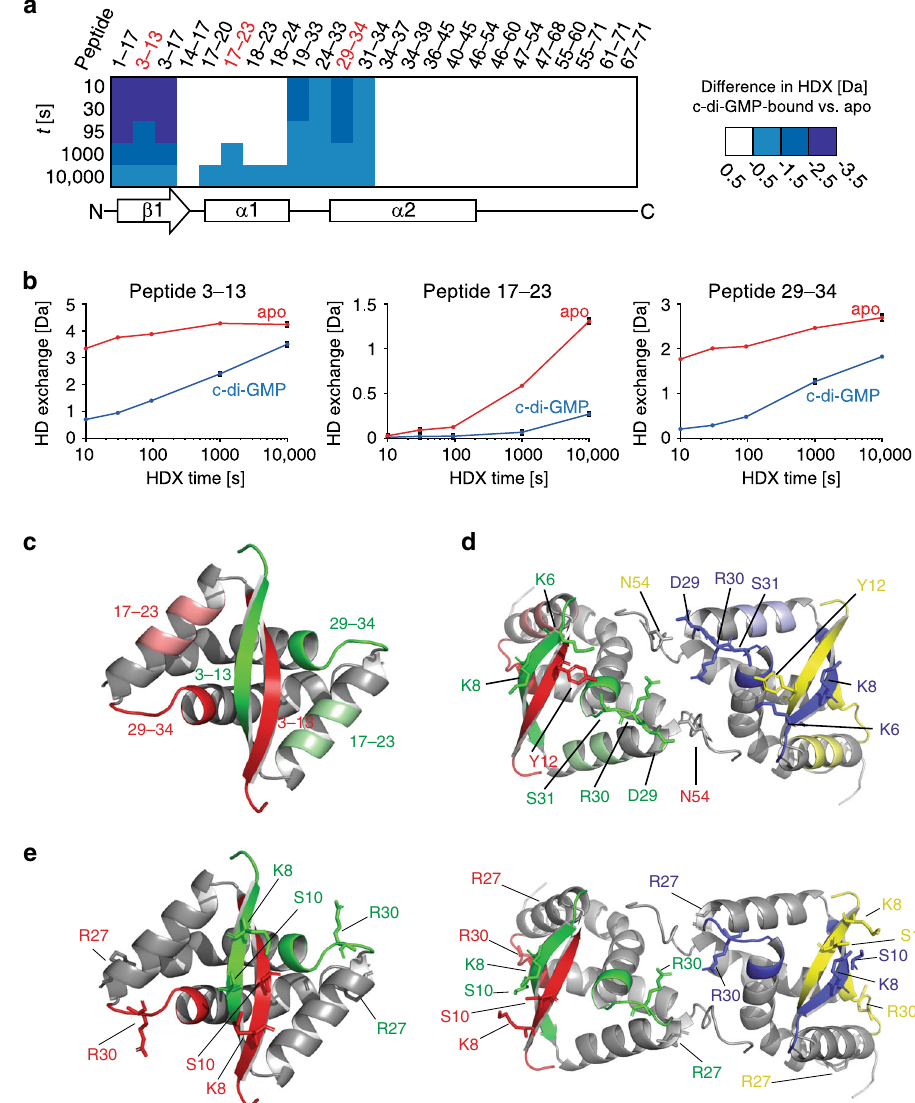
Fig. 3 HDX assay for CdbA in the presence and absence of c-di-GMP. a Representative peptides of CdbA are colored according to the difference in HDX between the c-di-GMP-bound and the apo-state. The secondary structure of CdbA is shown below. b HDX for three representative peptides of CdbA (marked red in panel a ) in the c-di-GMP-bound (blue) and apo-state (red). Data represent mean ± SD ( n = 3 separate reactions). c Location of the three representative peptides in b in the crystal structure of the CdbA dimer. d Location of the three representative peptides from b in the crystal structure of the CdbA tetramer with residues proposed to be involved in formation of the polar pocket for c-di-GMP binding indicated as sticks. e Crystal structure of CdbA dimer (left) and tetramer (right) with interface 1 and -2 of each monomer colored in red, green, yellow, and blue. Amino acids selected for site directed mutagenesis are